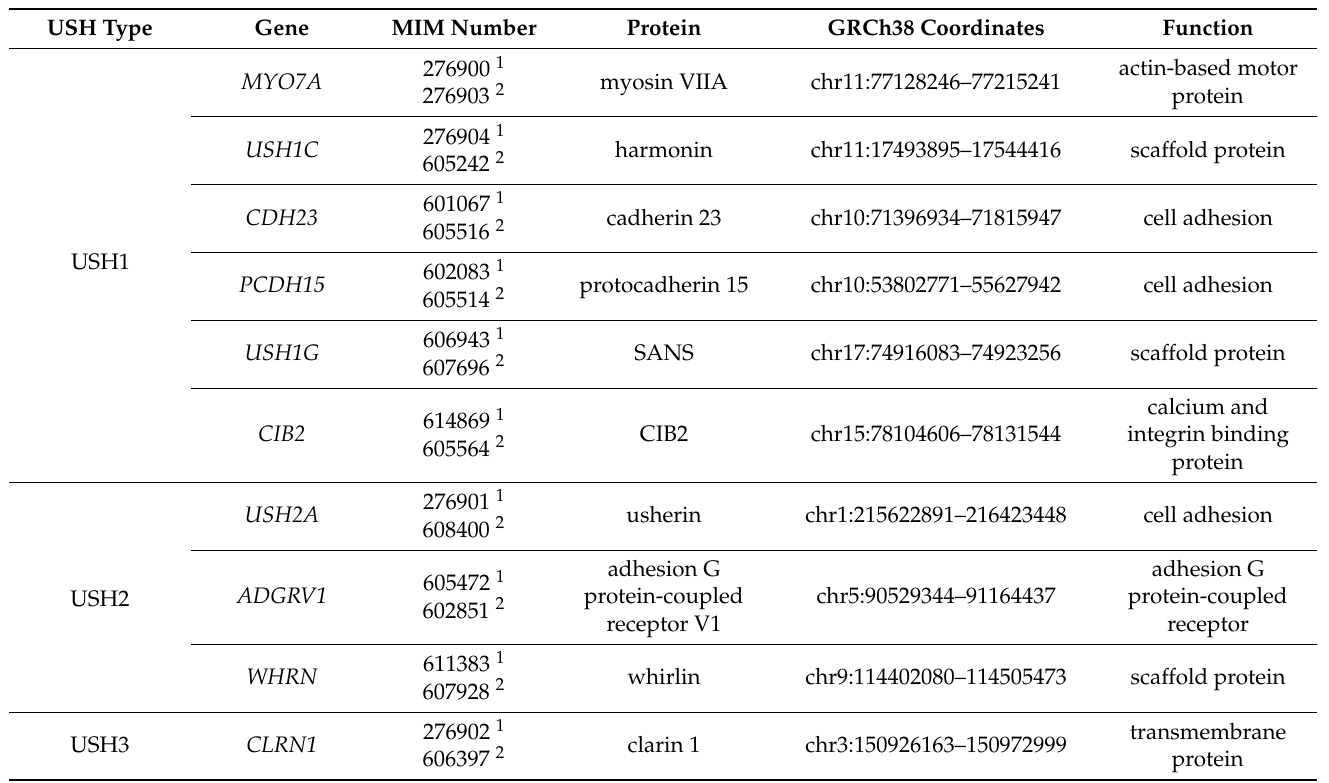
Table 1. Summary of the USH